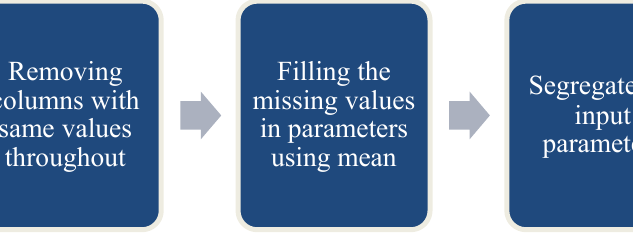
Figure 2. Data Figure 2. Data pre-processing.